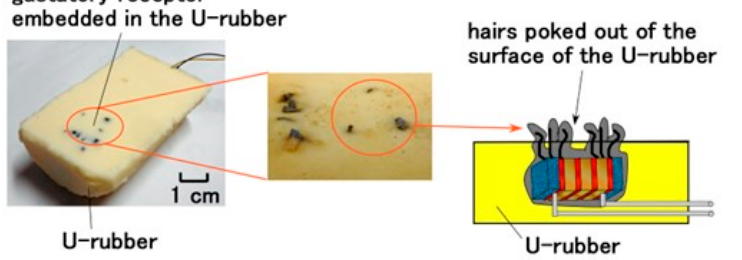
Figure 4. Images and configuration of the designed artificial tongue embedded with gustatory re-